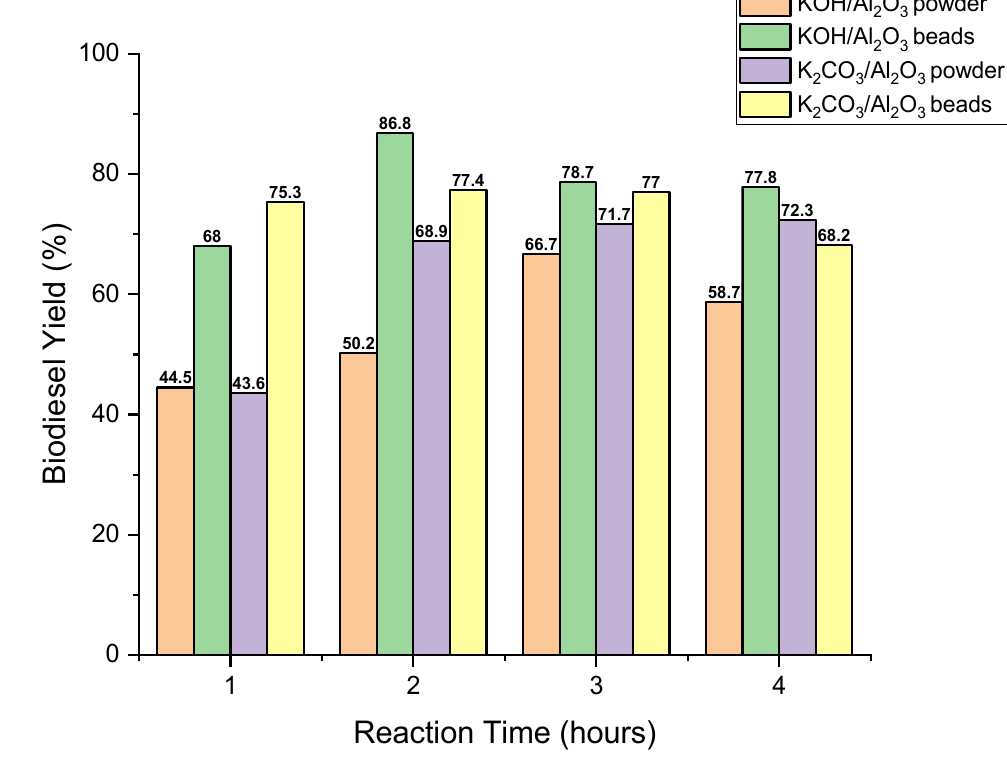
Figure 7. Percentage yield of pure biodiesel.